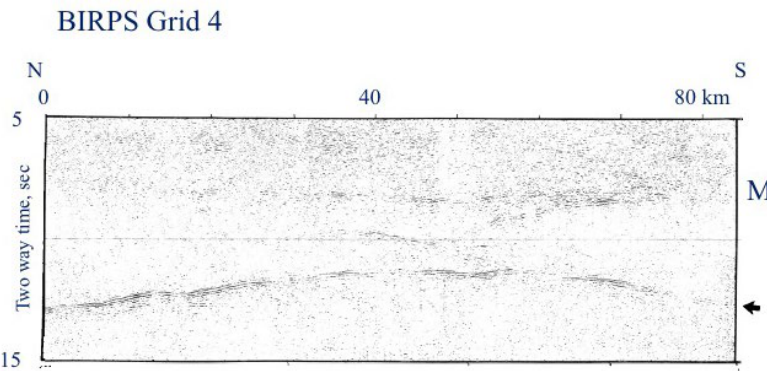
Figure 13. Strong, subhorizontal reflector in the mantle beneath northwest Great Britain from BIRPS marine data (After Snyder and Flack [86]). M indicates the position of the Moho at approximately 8 sec (ca 25 km). Note that the top of this section corresponds to 5 s TWTT instead of the customary 0 sec (surface).